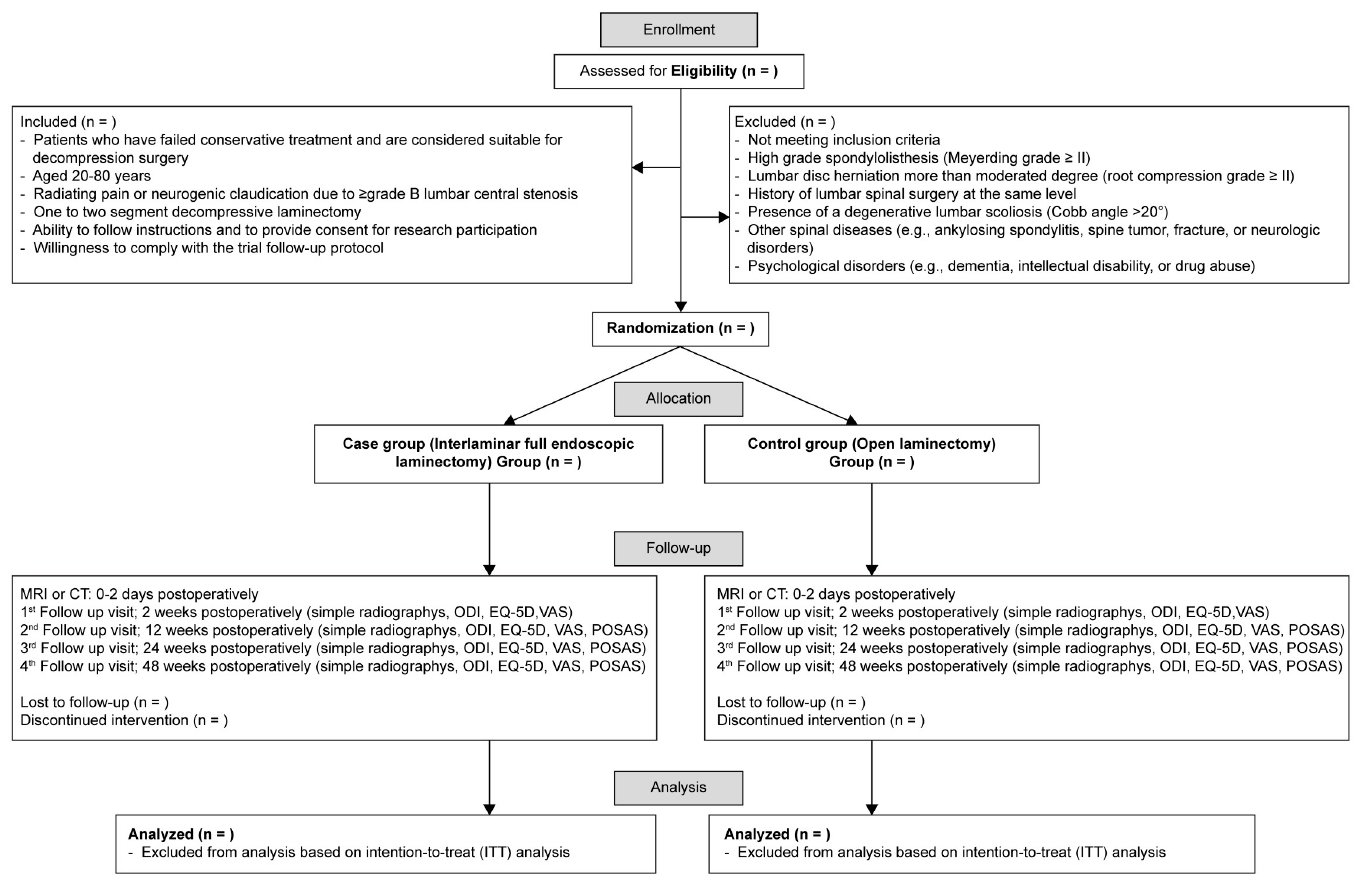
Fig 2. Protocol flow